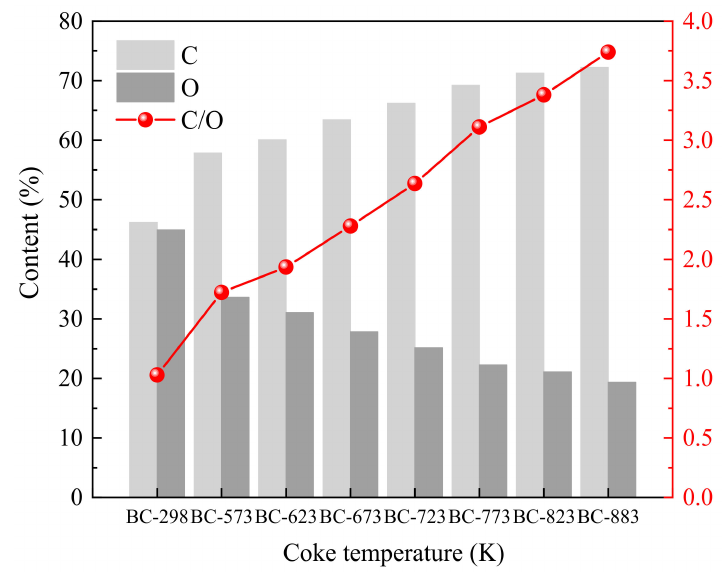
Figure 4. C, O and C/O content of semi-focal elements.